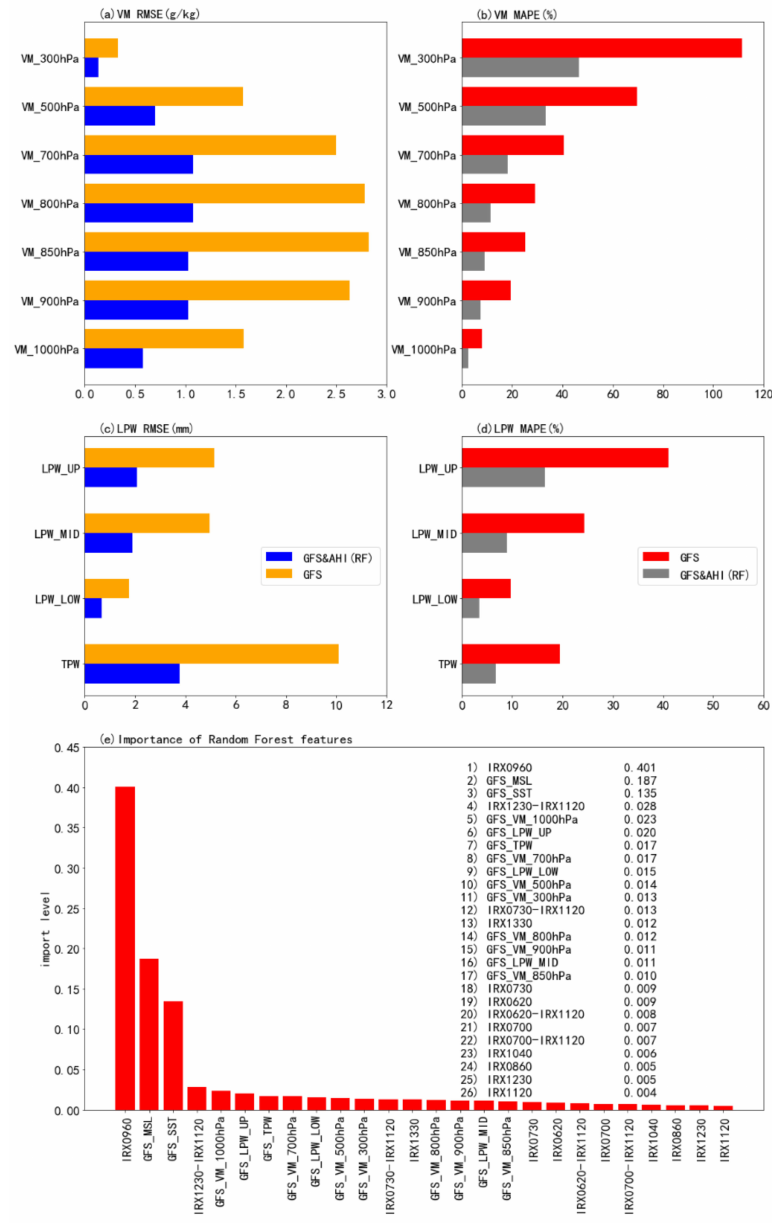
Figure 1. ( a , c ) RMSE and ( b , d ) MAPE evaluation results for the retrievals VM at different pressure levels and LPW at different atmospheric layers, respectively. ( e ) Importance ranking of inputs variations in the RF-based